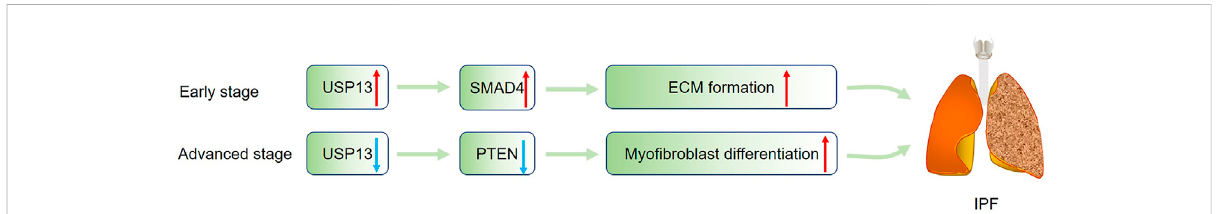
FIGURE 5 USP13inIPF.DuringtheprogressionofIPF,USP13isupregulatedtostabilizeSMAD4topromoteECMformationintheearlystage,andinthelate stage, hypoxia-induced USP13 reduction could lead to PTEN downregulation, facilitating myo fi broblast differentiation. Green arrow indicates upregulation; Blue arrow represents